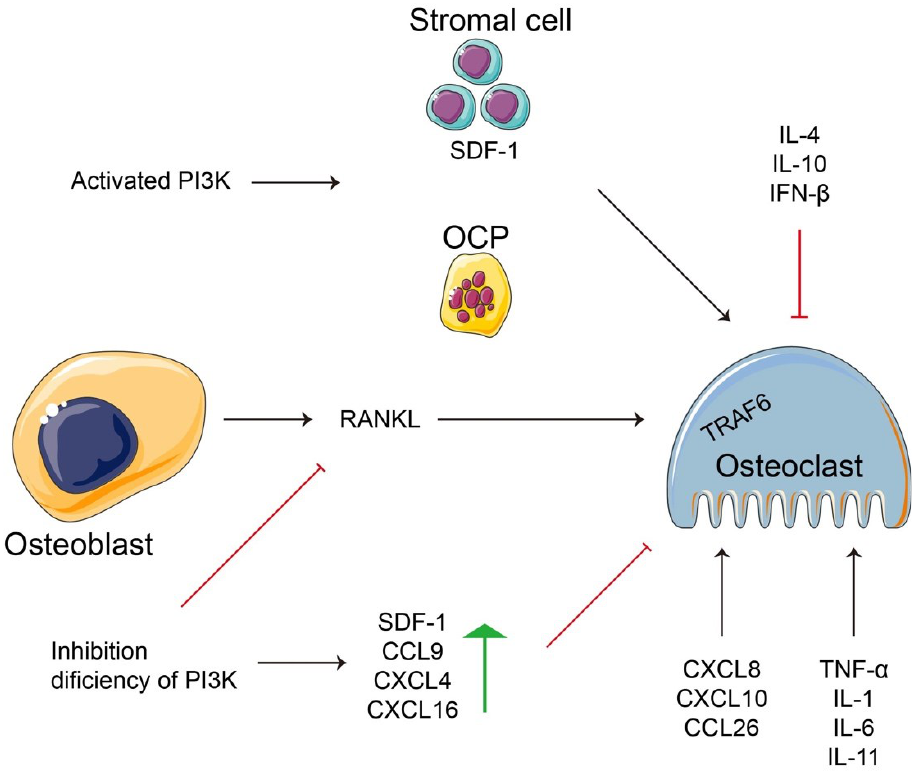
Figure 2. A schematic diagram of the relationship between inflammation and immunity for regulating osteoclastogenesis or osteoblast-dependent osteoclastogenesis. PI3K regulates the cell types (stromal cells, OCPs, osteoblasts, osteoclasts) to control cellular events, such as the release of anti- and/or pro-inflammation factors. Additionally, a few inflammatory factors not only implement their basic function according to their own definition, but are also involved in regulating various cells, such as osteoclastogenesis, or fused from OCPs.